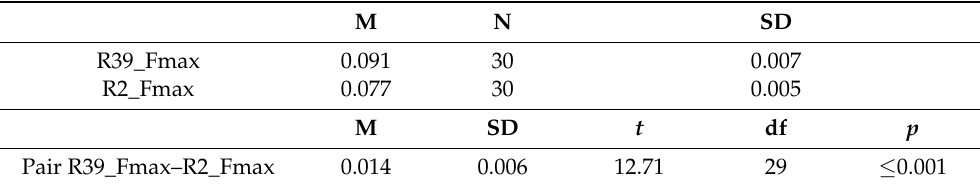
Table 5. Paired-samples test: pair R39_Fmax – R2_Fmax.